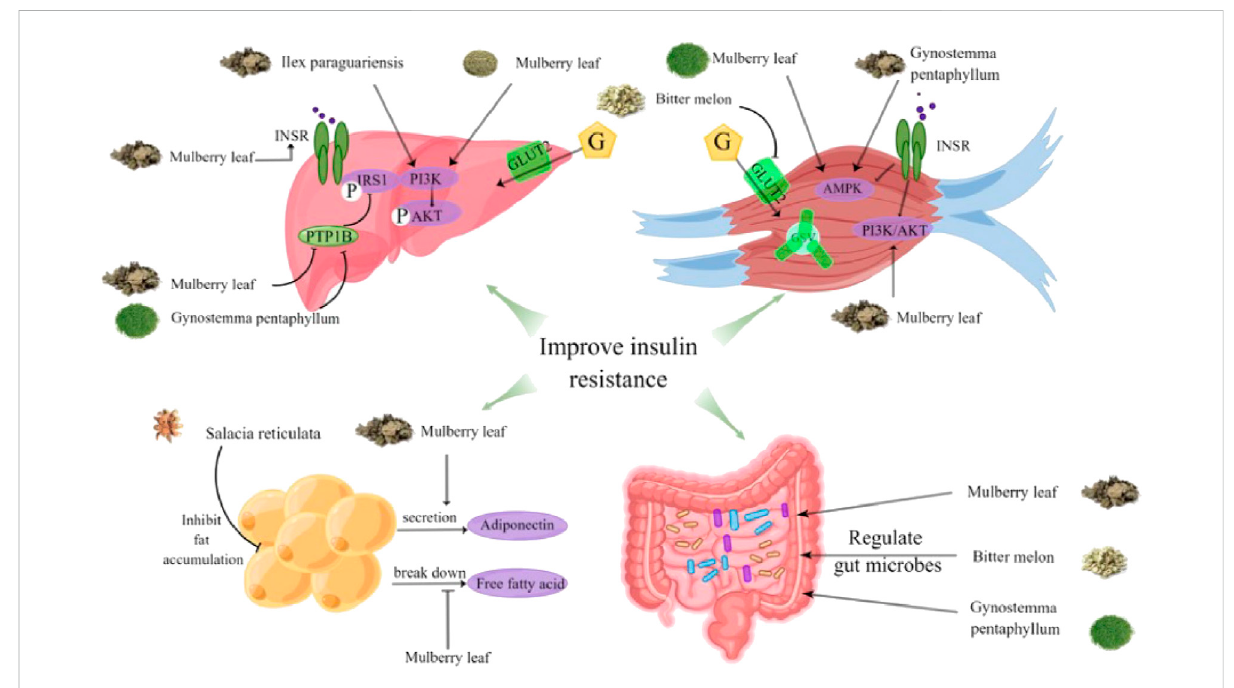
FIGURE 1 The effects of herbal teas in improving insulin resistance.